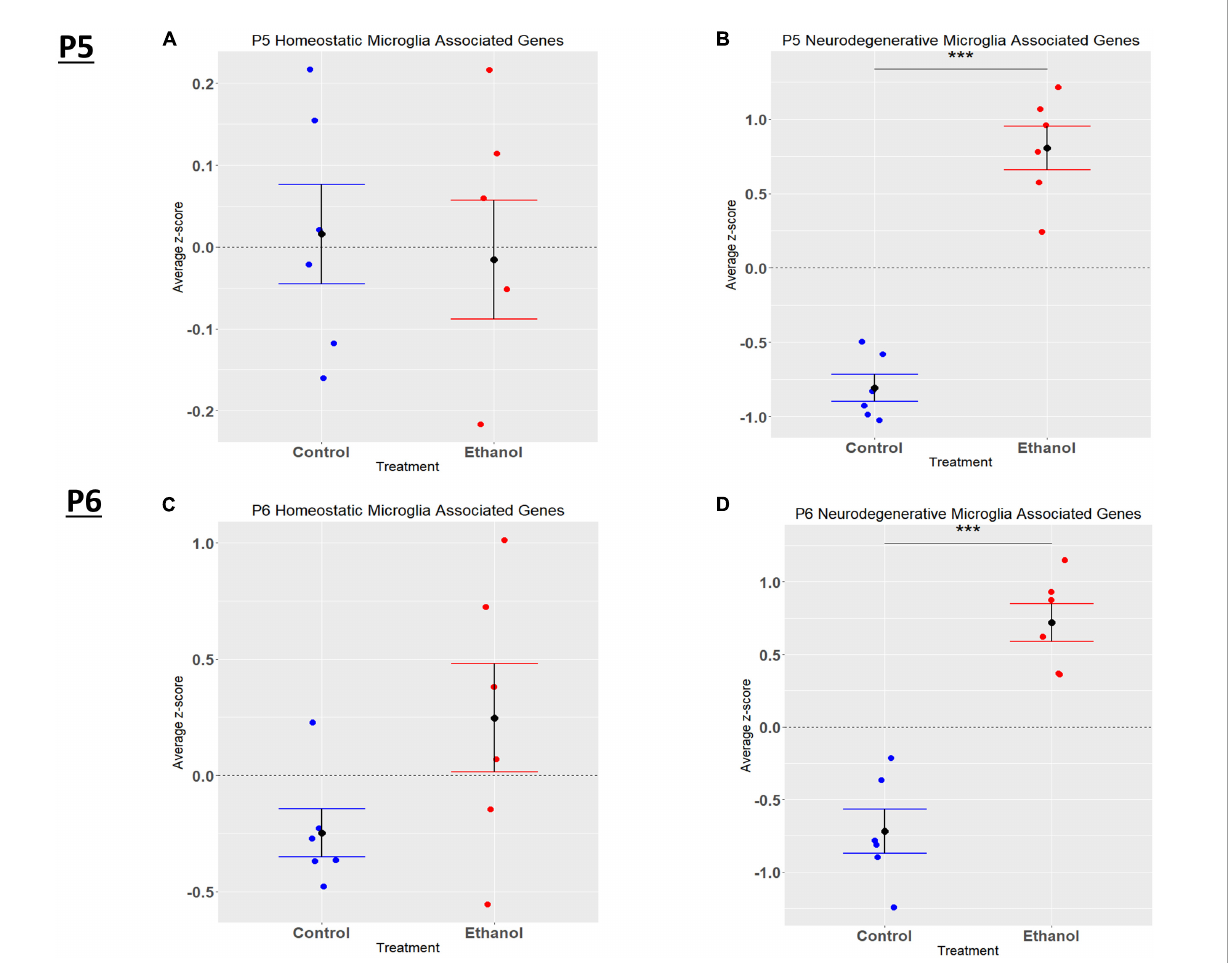
FIGURE4 Microglia associated genes altered by ethanol exposure at P5 and P6 in the cerebellum. Microglia associated genes were extracted as detailed in Methods. R statistical software was utilized to generate individual z-scores for each transcript of interest and each experimental animal. These z -scores were then averaged across transcripts for each individual animal. Control versus Ethanol groups were then tested for statistically significant variance in R by two-tailed, student’s t -test, and graphical results were generated. Quantification by average z -score of homeostatic microglia associated genes at P5 (A) and P6 (B) and neurodegenerative microglia associated genes at P5 (C) and P6 (D) . n = 3 males and 3 females per treatment group E or C; *** p <